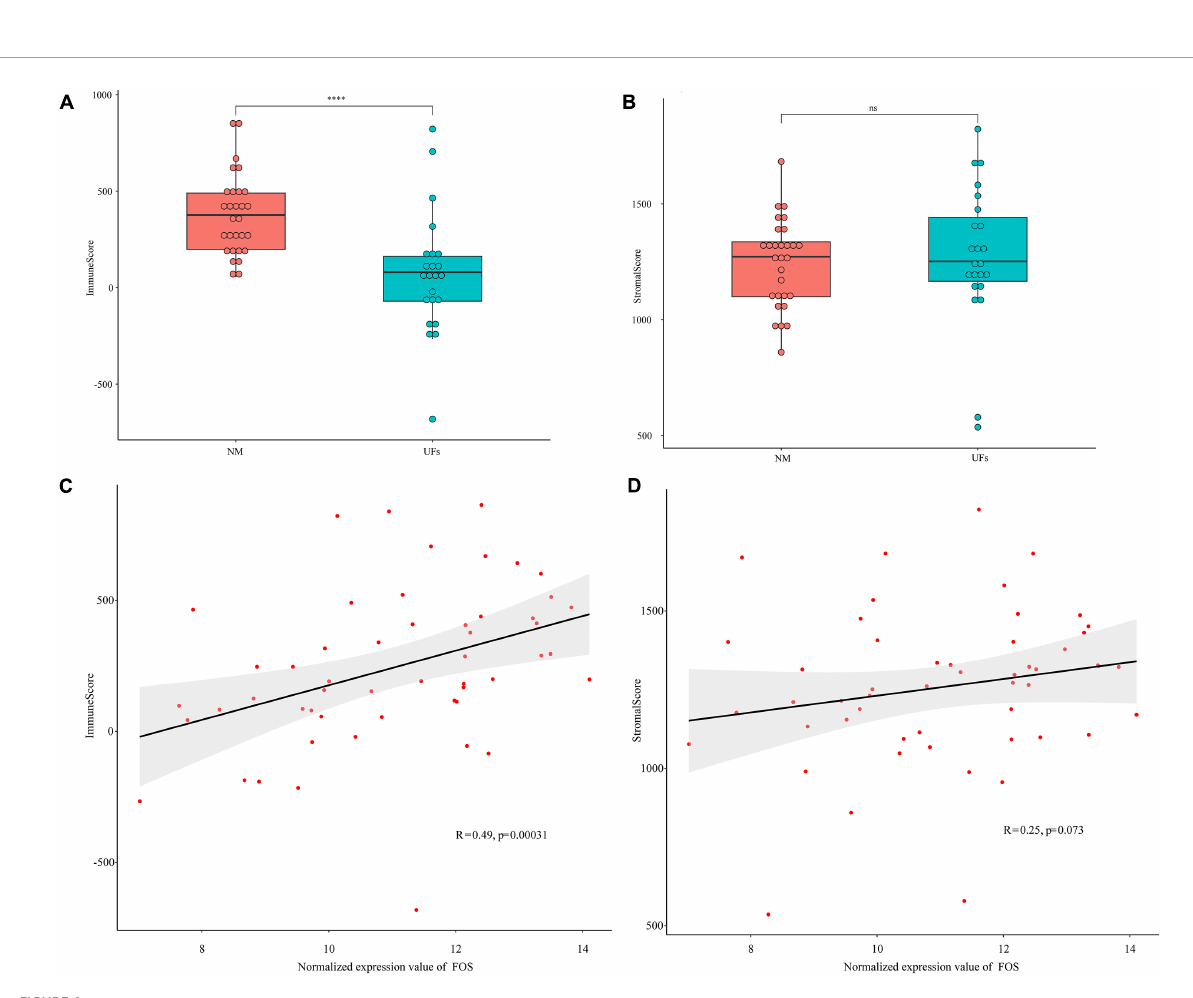
FIGURE4 Estimation of stromal and immune scores between the fibroid and normal myometrium tissue. (A) Immune scores in the two groups. (B) Stromal scores in the two groups. (C,D) Correlation between FOS and stromal scores as well as immune scores. ∗∗∗∗ P <